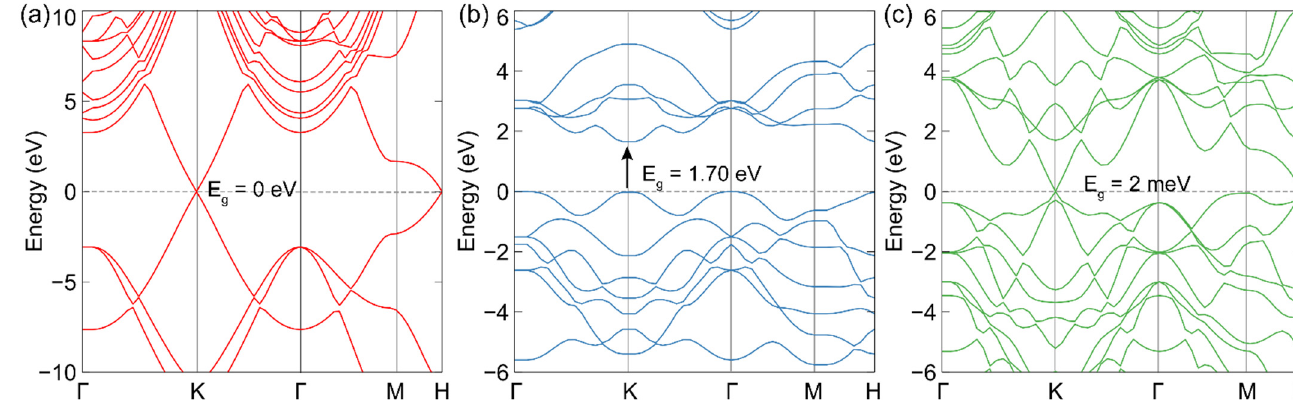
Figure 2. Theoretical band structure of simulated ( a ) graphene, ( b ) MoS 2 , and ( c ) graphene-MoS 2 .